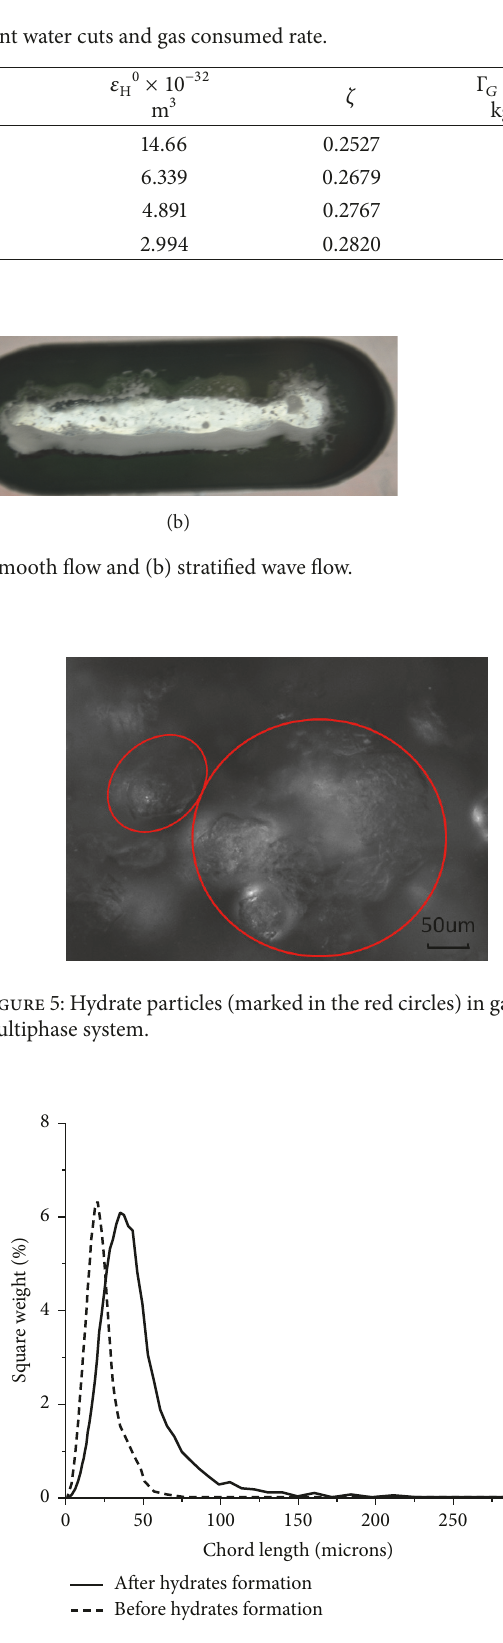
Figure 6: Chord length distribution before and after hydrates